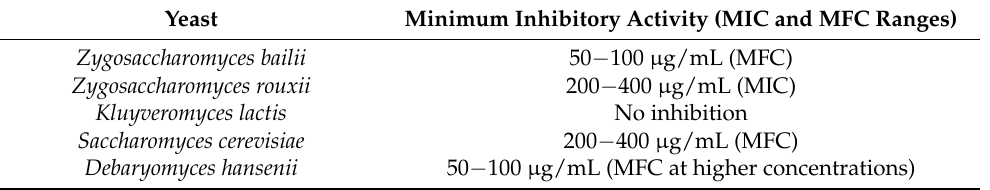
Table 1. Minimum inhibitory concentration (MIC) and minimum fungicidal concentration (MFC) of the peptide against the five yeast.